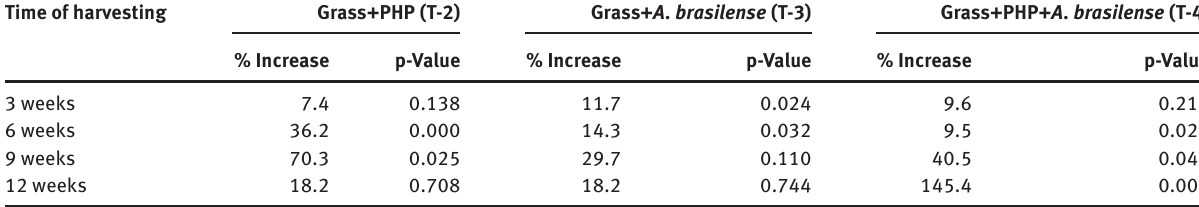
Table 1 Percentage increase of shoot dry weights and their statistical significance levels (p-values) compared to controls which do not have any PHP or bacterium.